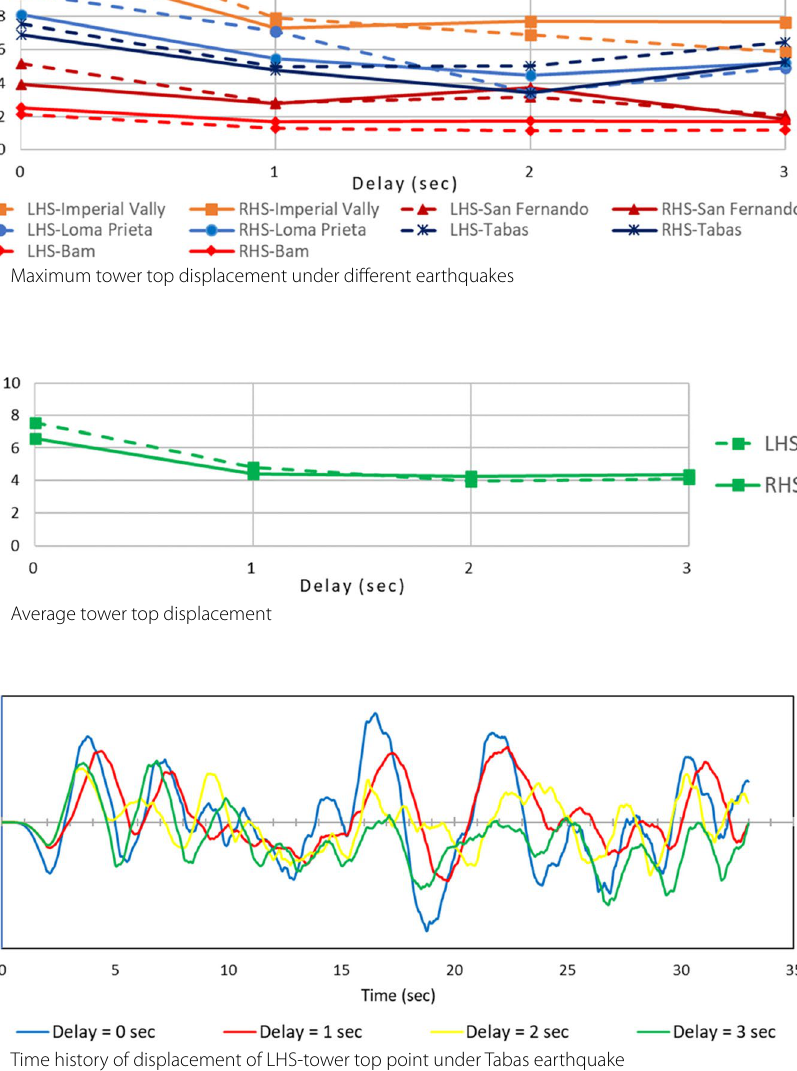
ones depending on the earthquake excitation delay time. In all cases, considerable energy is favorably dissipated in the isolators.